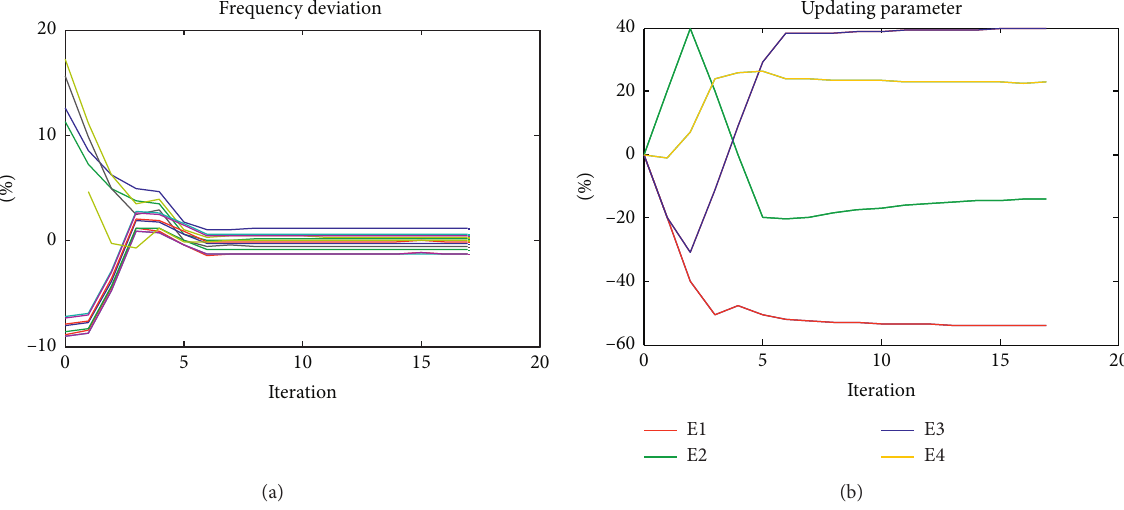
Figure 25: Updating process using RTM and frequency data.